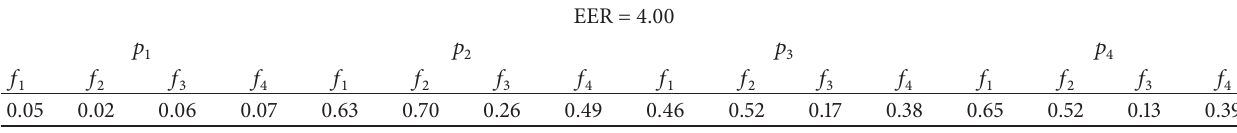
Table 13: Equal error rate with 16 images with optimized weights.